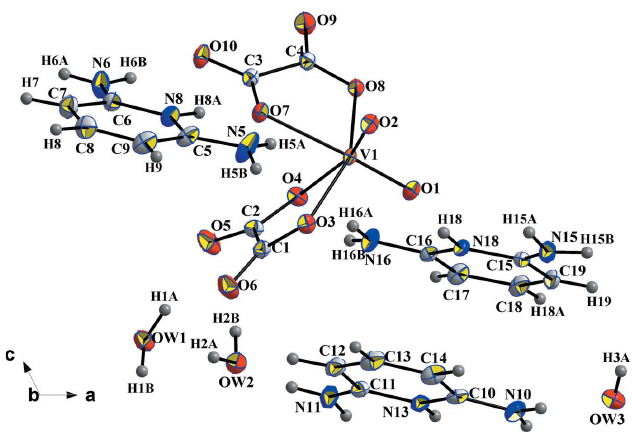
Figure 1 The asymmetric unit of (I) showing the atom-numbering scheme. Displacement ellipsoids are drawn at the 50% probability level for non-H